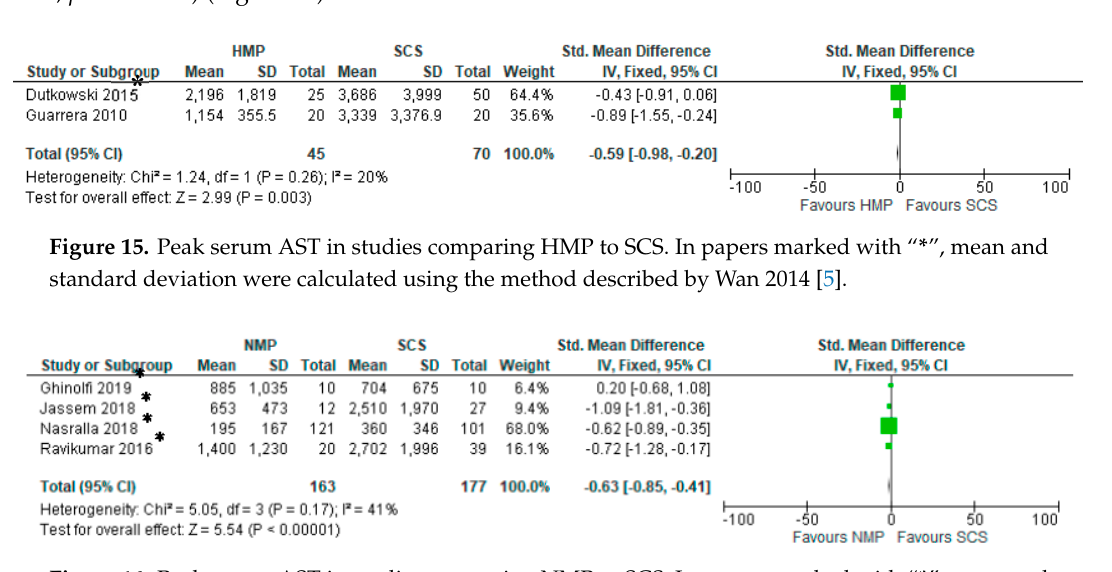
Figure 14. Early allograft dysfunction in livers preserved via NMP and SCS.